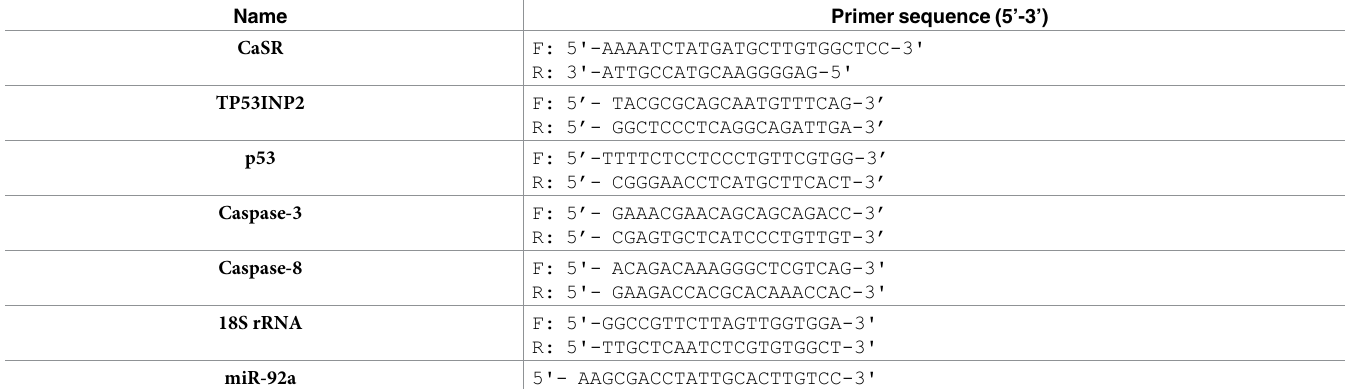
Table 1. Sequences of primers used for